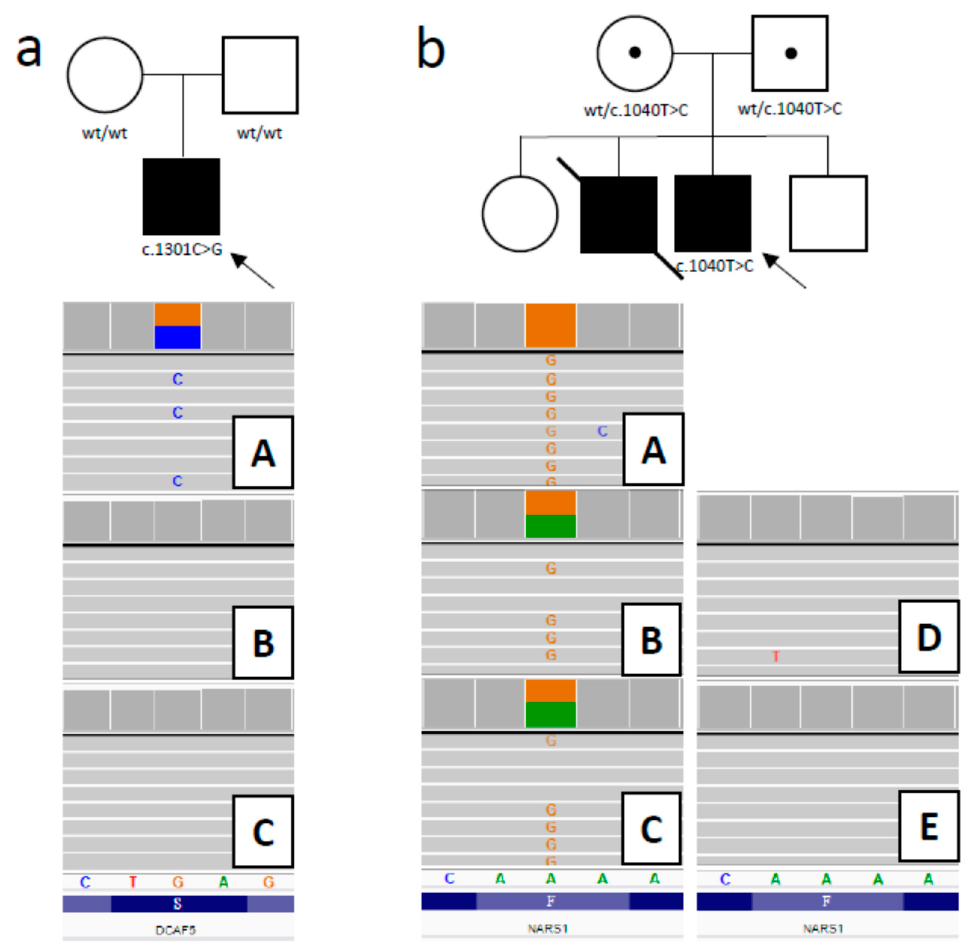
Figure 1. Family study results. ( a ) Heterozygous stop-gained mutation c.1301C>G in DCAF5 was confirmed in patient ( A ) and excluded in the patient’s parents ( B —mother, C —father) (family on the left). ( b ) Homozygous missensse mutation c.1040T>C in NARS1 ( A - patient). Parents proved to be carriers ( B —mother, C —father), and the siblings are wild-type homozygotes ( D —brother, E —sister) (family on the right). Circle represents female, square indicates male, filled symbol indicates affected individual, proband is marked with a black arrow; wt—wild-type.